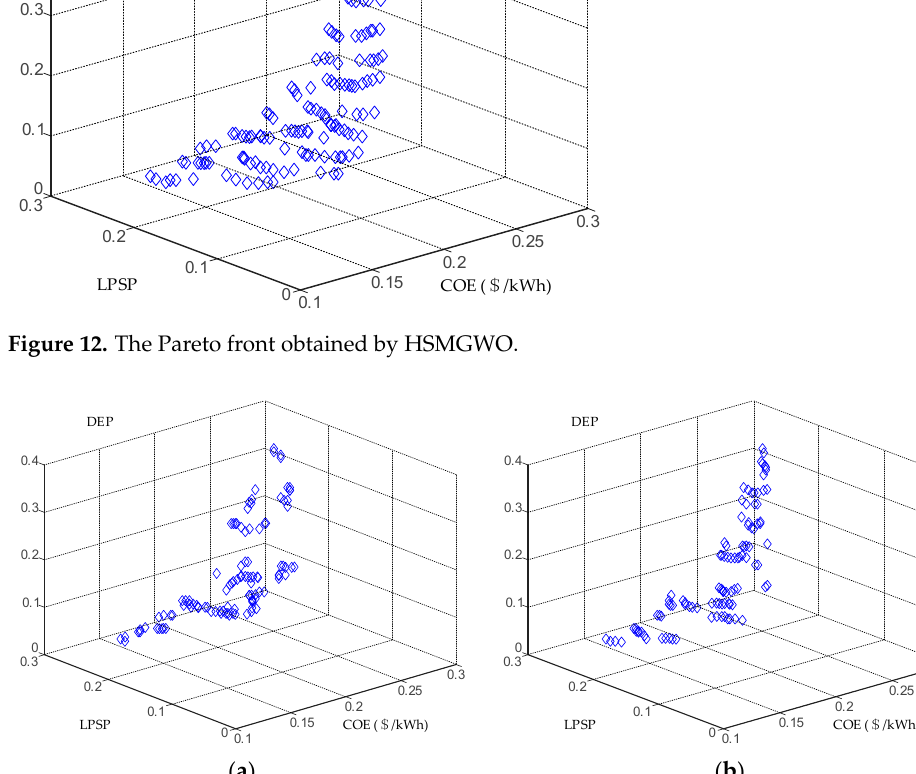
Figure 13. The Pareto front obtained by ( a ) MOPSO; ( b ) MOGWO.